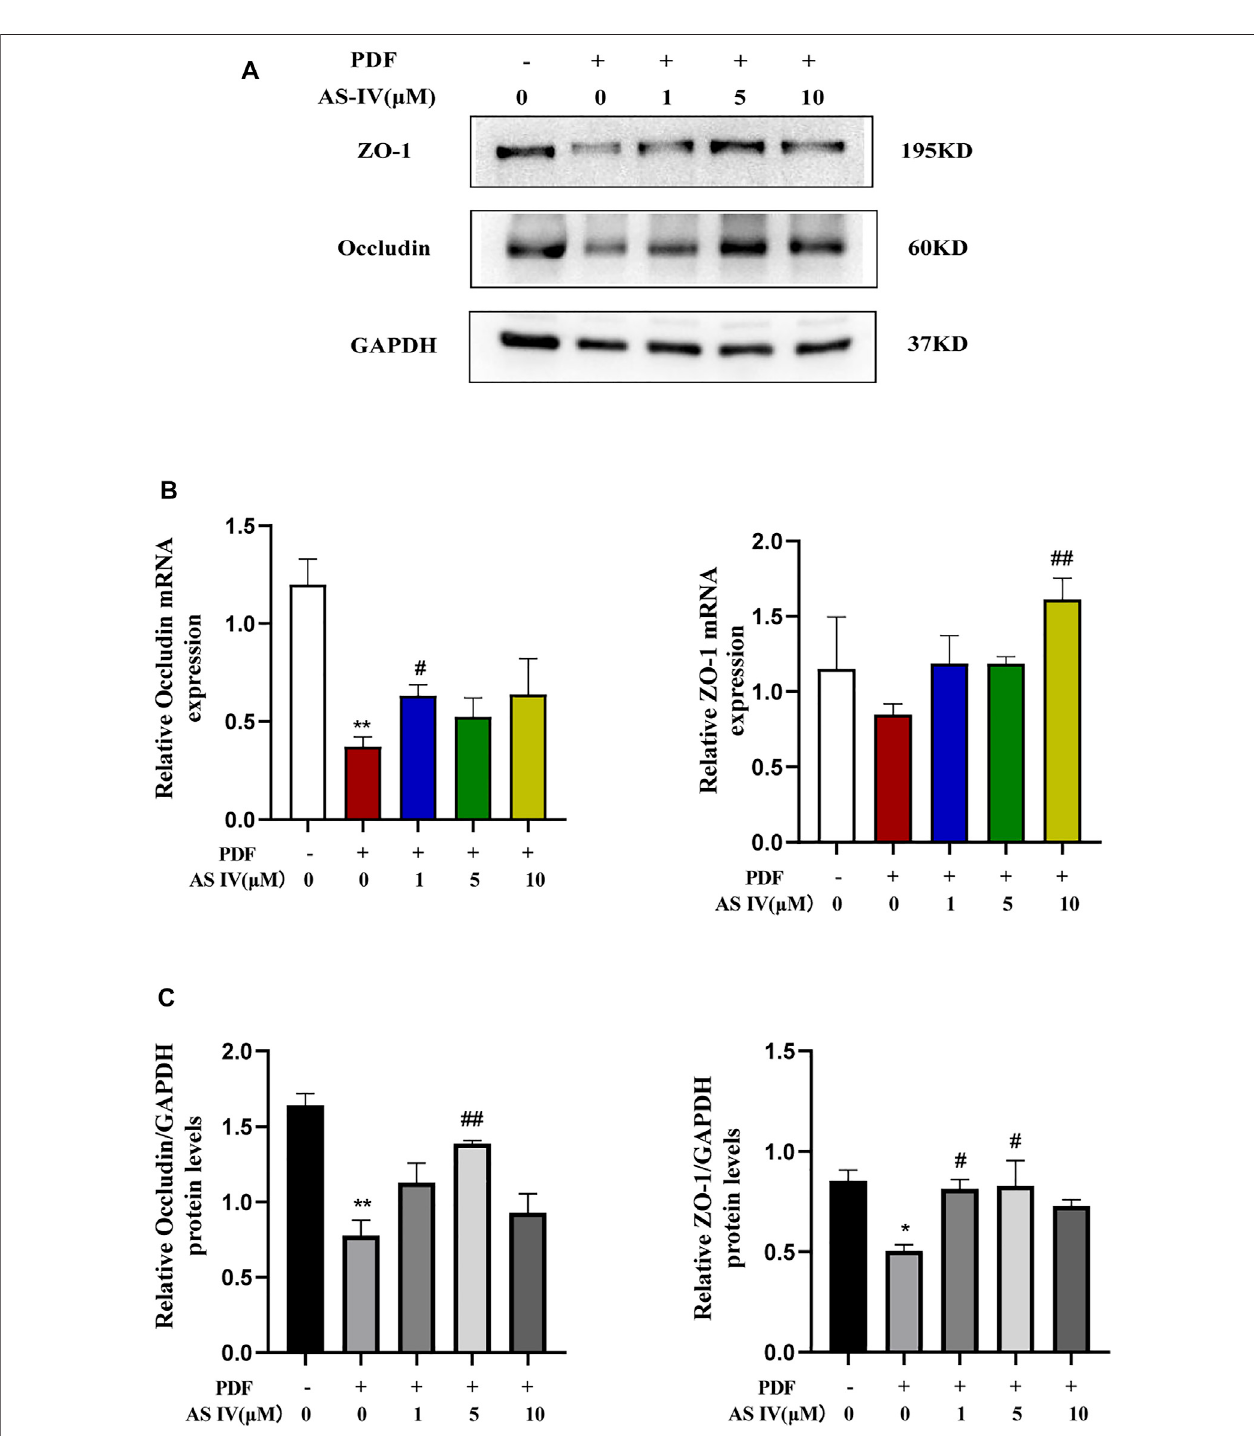
FIGURE4| EffectsofASIVontheexpressionoftightjunctionproteinsinPDF-treatedT84cells (A,B) T84cellswereincubatedwithPDFand1,5,and10 μ MASIV, then theprotein expression levels ofoccludin and ZO-1 were determined by western blotting analysis (C) T84 cells were incubated withPDF and 1, 5, and 10 μ M ASIV, thenthemRNAlevelsofoccludinandZO-1weredeterminedbyReal-timePCR.Dataarepresentedasmeans±SDofthreeindependentexperiments.* p < 0.05or** p < 0.01 versus the control group. # p < 0.05 or ## p < 0.01 versus the PD group.